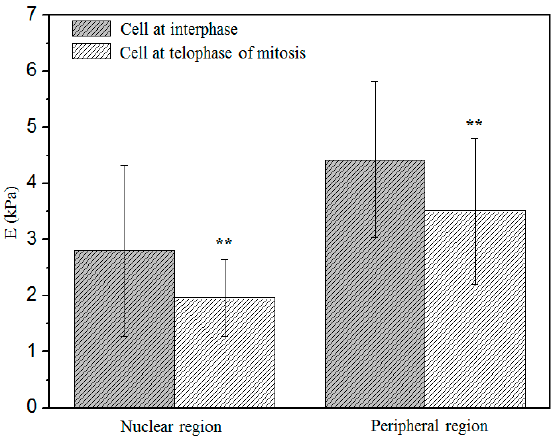
Figure 7. Comparison of the elastic modulus of cells at the interphase and the telophase of mitosis. Data are presented as mean ± standard error of the mean (** denoted p < 0.01).